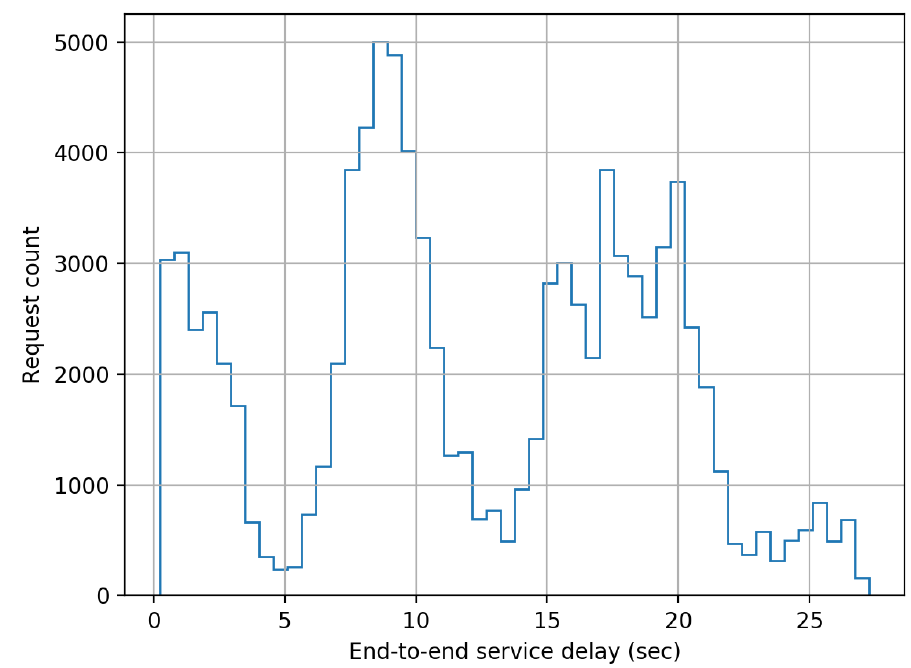
Figure 8. Distribution of end-to-end service delay at a mean request rate of 19